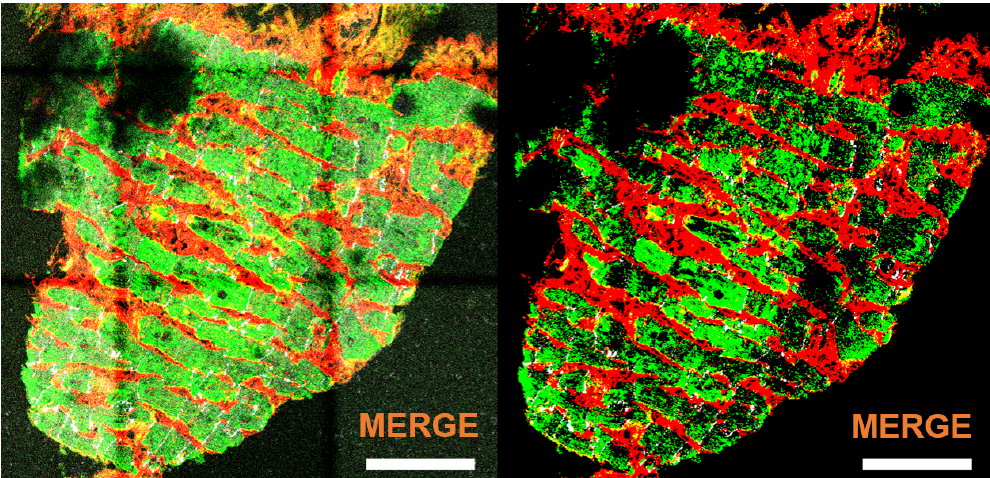
Figure 5. Merged channels for image a before ( left ) and after ( right ) noise removal. Scale bar = 100 µ